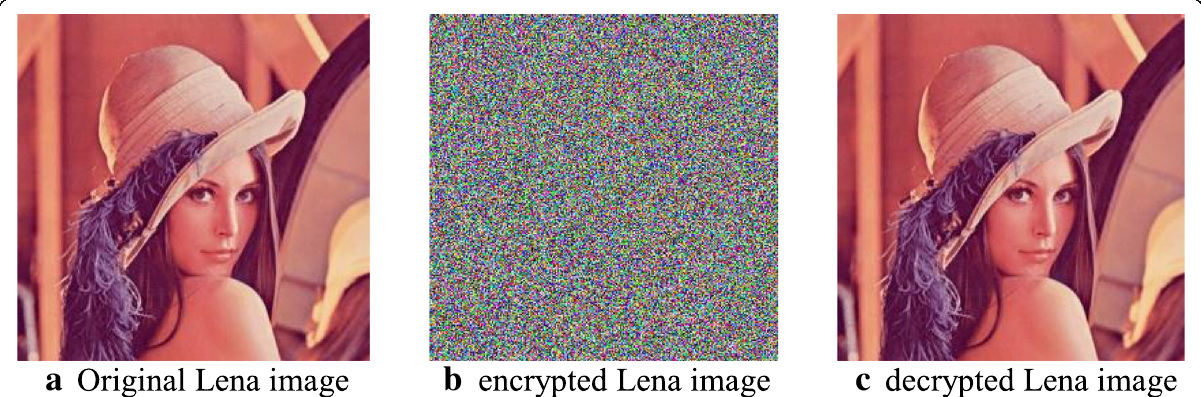
Fig. 3 Encryption and decryption results. a Original Lena image; b encrypted Lena image; c decrypted Lena